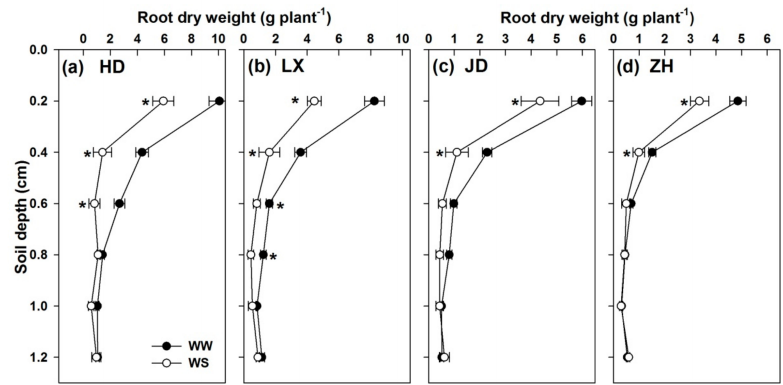
Figure 7. Root dry weight distribution at di ff erent soil depths in four soybean genotypes (two landraces: Huangsedadou (HD), Longxixiaohuangpi (LX), and two recent cultivars: Jindou 19 (JD) and Zhonghuang (ZH)) under well-watered (WW) and cyclical water stress (WS) imposed from 40 days after sowing in the pot experiment in 2014. Note the changes in the x -axes of ( a , b ) from ( c , d ). The bars indicate one standard error of the mean ( n = 4). The * indicates that the root dry weights were significantly di ff erent ( p = 0.05) between the WW and WS treatments at the same soil